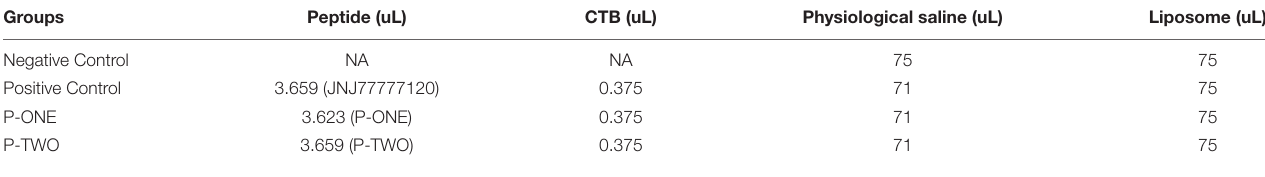
TABLE 1 | Vaccine preparation for different experimental and control groups.